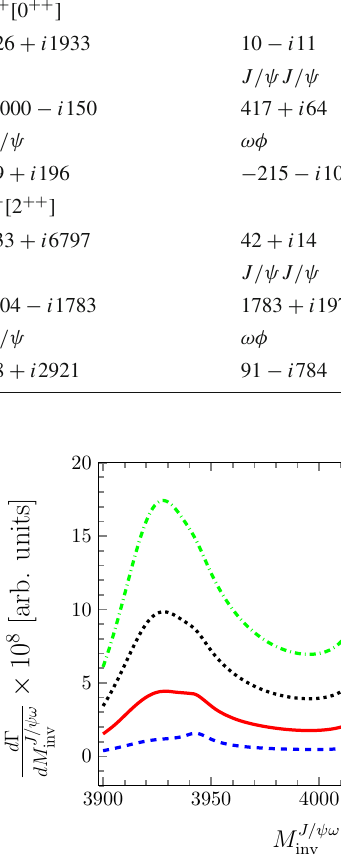
Table 1 Couplings g i of the 0 ++ and 2 ++ resonances to the relevant channels, in units of MeV